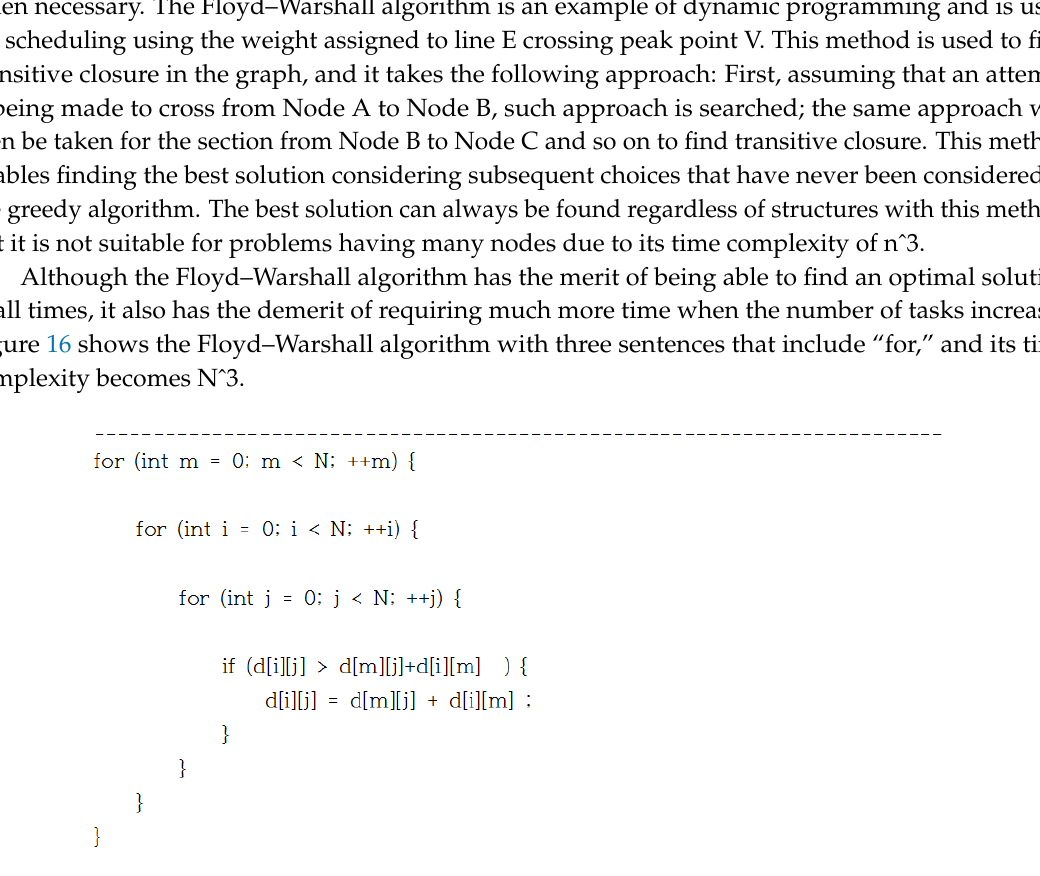
Table 3. The Result of Scheduling and Runtime Obtained by Executing the Source Implemented based on the Floy-Warshall algorithm (a Dynamic Programming).